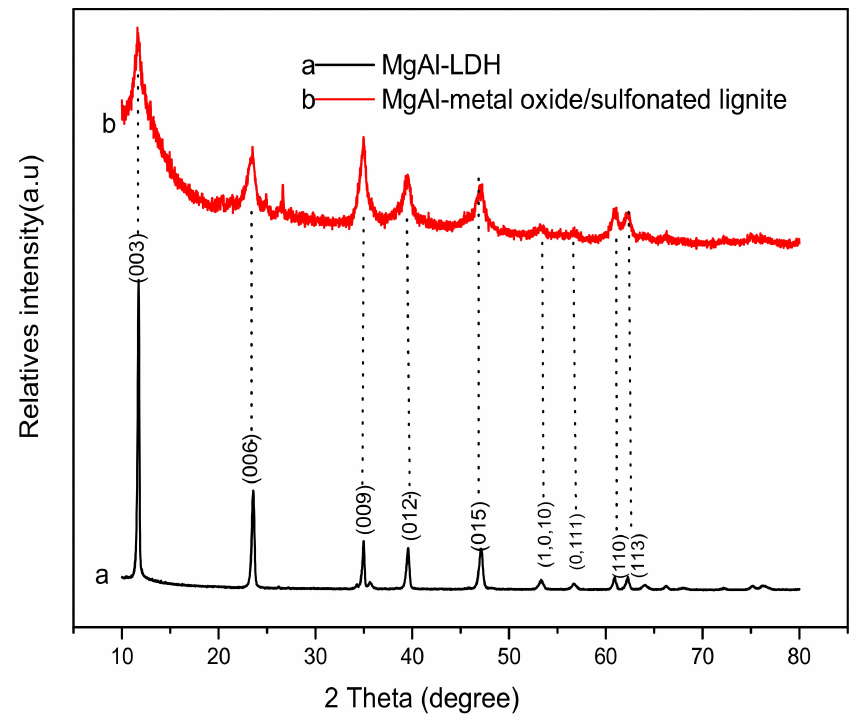
Figure 4. XRD patterns of ( a ) Mg-Al LDH and ( b ) Mg-Al metal oxides after the adsorption of sulfonated